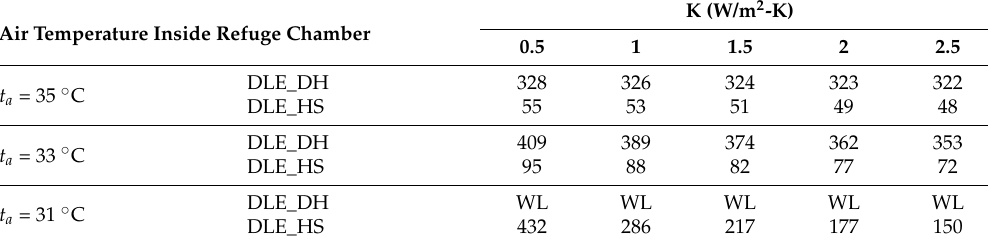
Table 3. The duration limit of exposure (min) for various overall heat transfer coefficient of the wall of refuge chamber (K) and air temperature inside refuge chamber ( t a